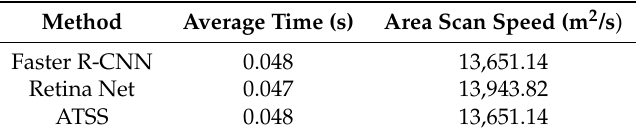
Table 4. Processing time evaluation of the